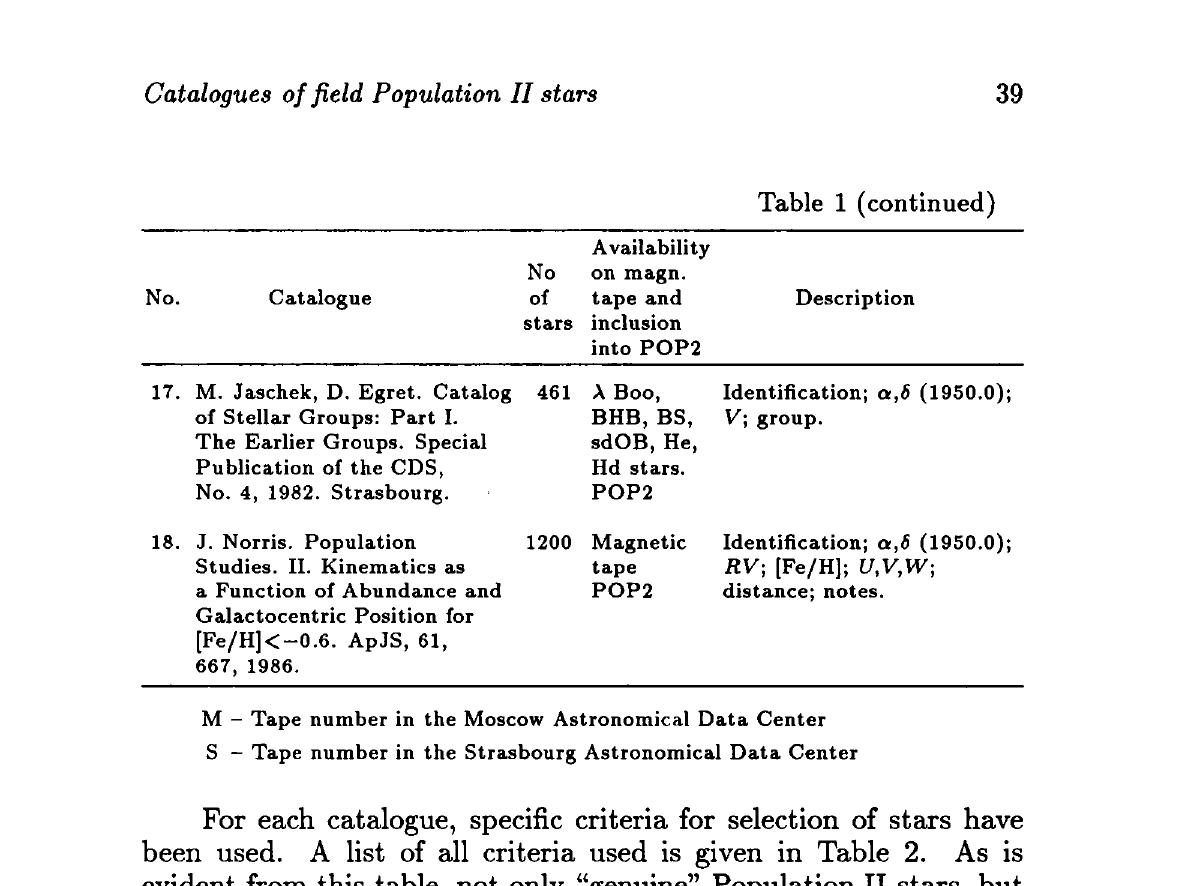
Table 2. Selection criteria of the field Population II